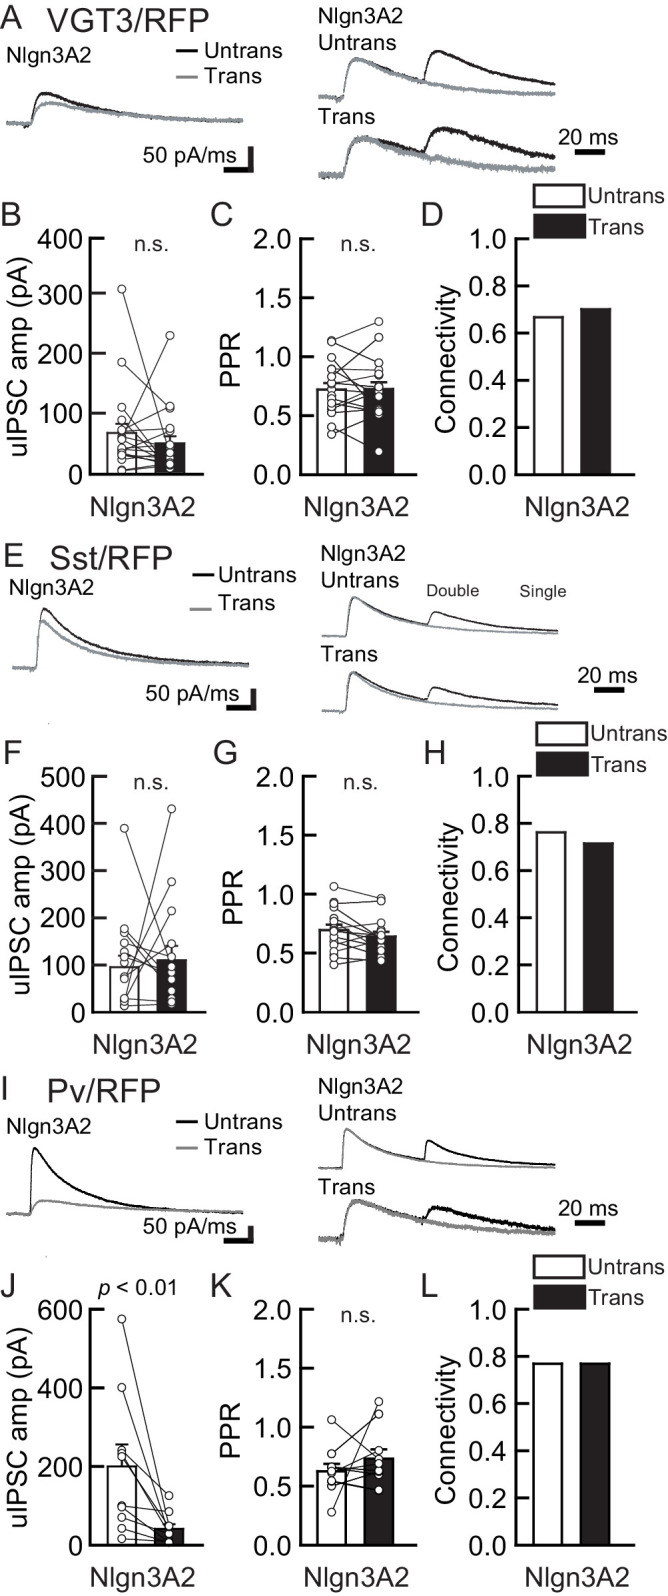
Nlgn3A2 overexpression (OE) does not increase VGT3+, Pv+, and Sst+ interneuron-mediated unitary synaptic transmission.The effects of Nlgn3A2 isoform OE in hippocampal CA1 pyramidal neurons were compared between inhibitory inputs mediated by VGT3+ (A–D), Pv+ (E–H), and Sst+ (I–L) inhibitory interneurons. (A, E, and I) Sample traces of unitary inhibitory postsynaptic currents (uIPSCs). Left, superimposed averaged sample uIPSC traces (Untrans: black; trans: dark gray) induced by an action potential (AP). Middle and right, superimposed averaged sample traces of uIPSCs evoked by single (dark gray) and double (black) APs in Pv+ and Sst+ interneurons. uIPSCs are normalized to the first amplitude. The amplitude (B, F, and J) and paired-pulse ratio (PPR) (C, G, and K) of uIPSCs were plotted for each pair of transfected (Trans) and neighboring untransfected (Untrans) cells (open symbols). Bar graphs indicate mean ± SEM. (D, H, and L) Synaptic connectivity between presynaptic inhibitory interneuron and postsynaptic untransfected (open bars) or transfected (black) pyramidal neurons. Numbers of cell pairs: Nlgn3A2 at VGT3+ synapse (30 pairs/7 mice), Pv+ synapse (13/4), and Sst+ synapses (21/5). The number of tested slice cultures is the same as that of cell pairs. n.s., not significant. Mann–Whitney U-test.